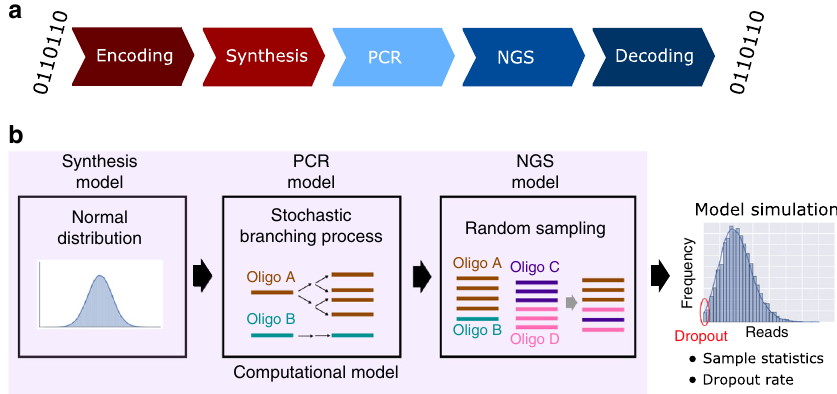
Fig. 1 A DNA storage system model. a Work fl ow of DNA data storage. Digital information is fi rst encoded into oligonucleotide (oligo) sequences, resulting in multiple 150-base DNA fragments synthesized using array-based DNA synthesis technology, which are then stored. To read back the stored data, target DNA oligos can be selectively (random-) accessed using polymer chain reaction (PCR), then sequenced via next generation sequencing (NGS), and decoded back to digital information. b The computational model approximates each molecular process in the DNA storage system: it uses a normal distribution for modeling sequence copy numbers from synthesis, a stochastic branching process for PCR, and random sampling for sequencing. The computational model makes predictions for oligo copy distribution to help researchers estimate statistics such as sequence dropout